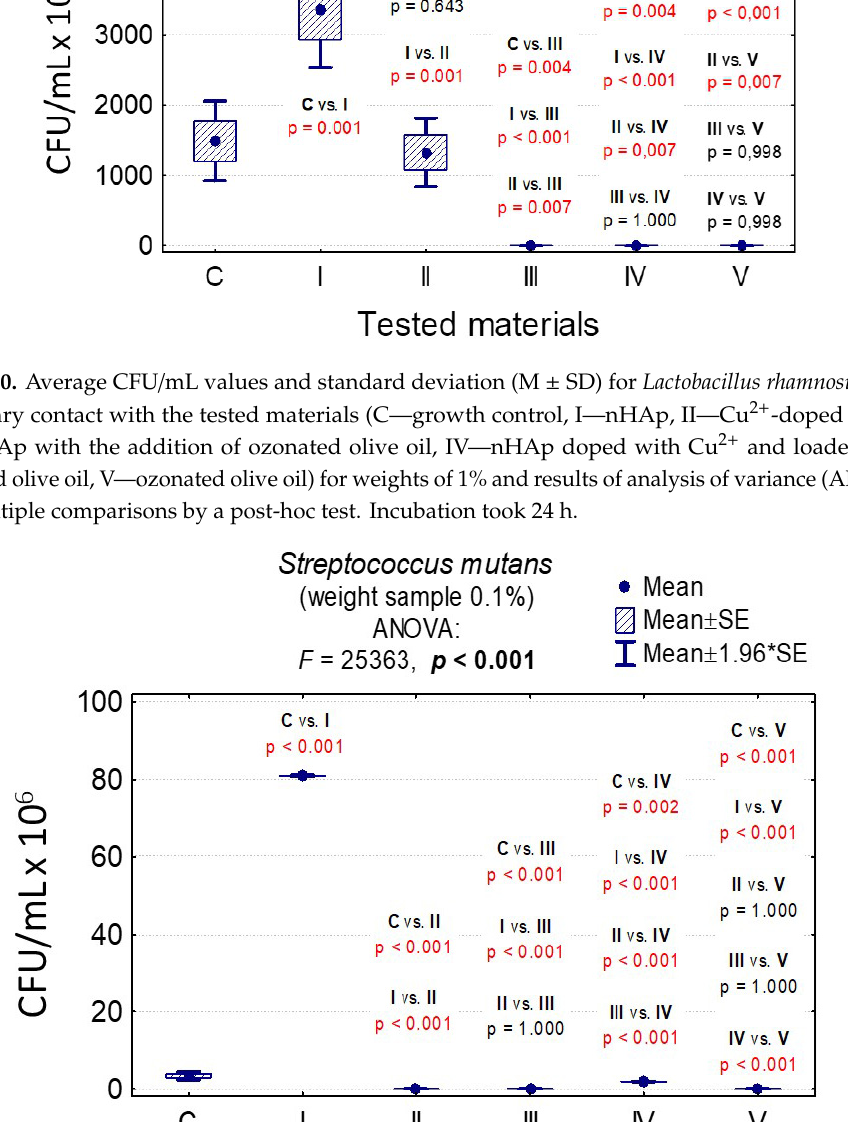
Figure 11. Average CFU / mL values and standard deviation (M ± SD) for Streptococcus mutans after temporary contact with the tested materials (C—growth control, I—nHAp, II—Cu 2 + -doped nHAp, III—nHAp with the addition of ozonated olive oil, IV—nHAp doped with Cu 2 + ions and loaded with ozonated olive oil, V—ozonated olive oil) for weights of 0.1% and results of the analysis of variance (ANOVA) and multiple comparisons by a post-hoc test. Incubation took 24